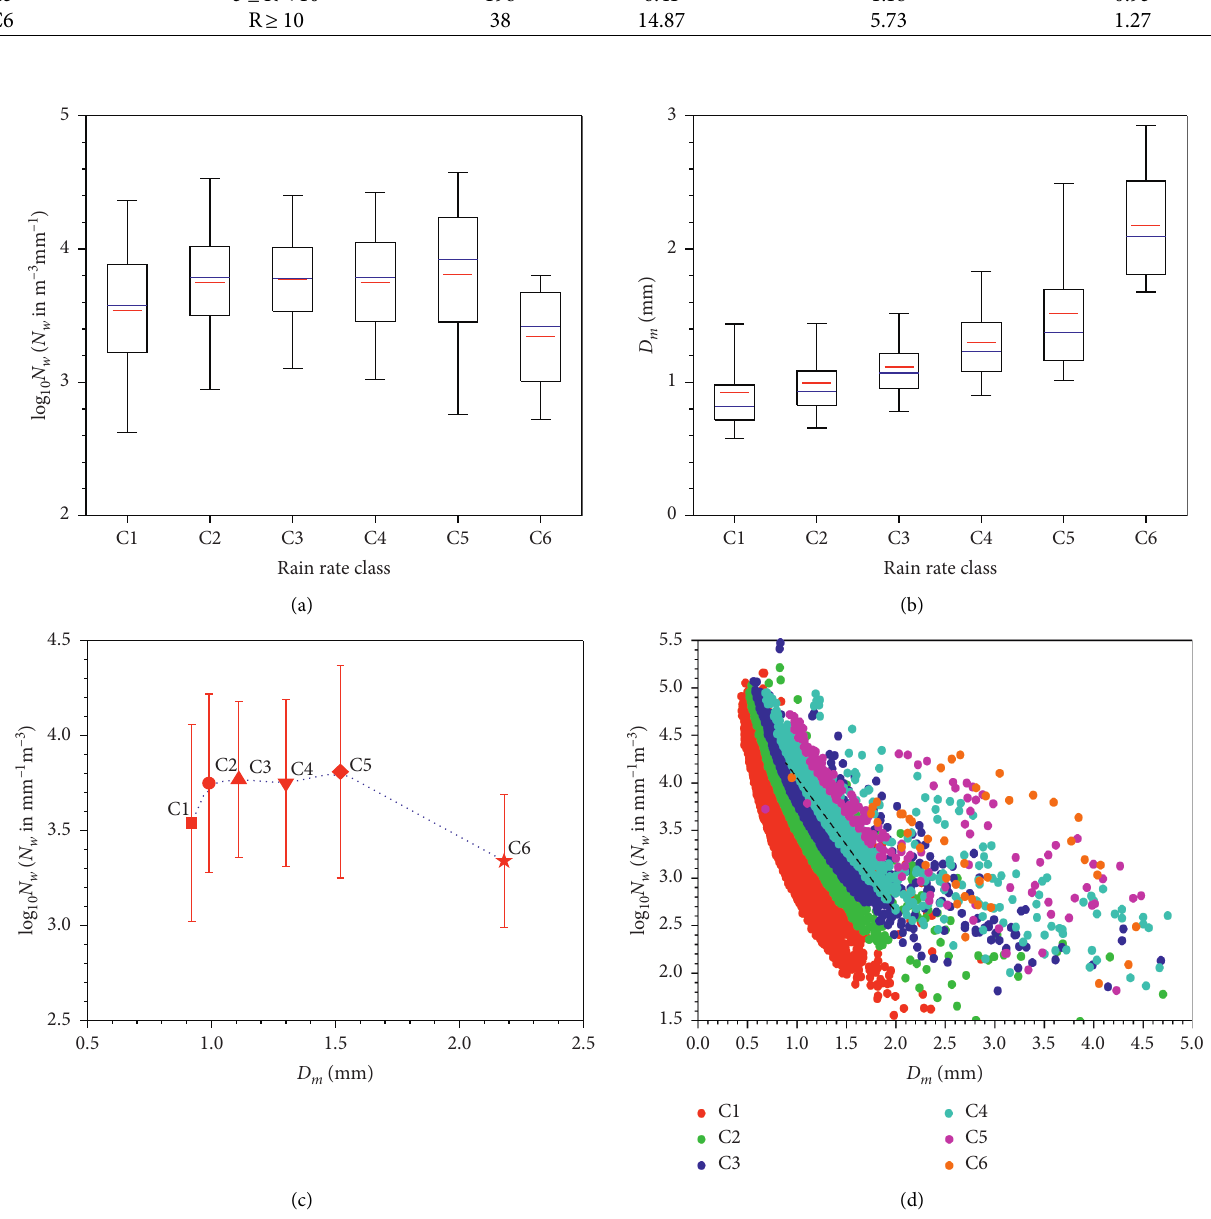
Figure 8: Variation of the normalized intercept parameter (a) and the mass-weighted mean diameter (b) for different rain rate classes. The blue central line of the box indicates the median, the red central line in the box indicates the mean values, and the bottom and top lines of the box indicate the 25 th and 75 th percentiles, respectively. The bottom and top lines of the vertical lines out of the box indicate the 5 th and 95 th percentiles, respectively. Variation of mean normalized intercept parameter (along with ± 1 standard deviation) with a mass-weighted mean N D diameter in different rain classes (c). Scatterplot of log w versus m for different rain rate classes (d). The black dashed line is the 10 N − D log w m relationship for stratiform rain reported by Bringi et al. 10